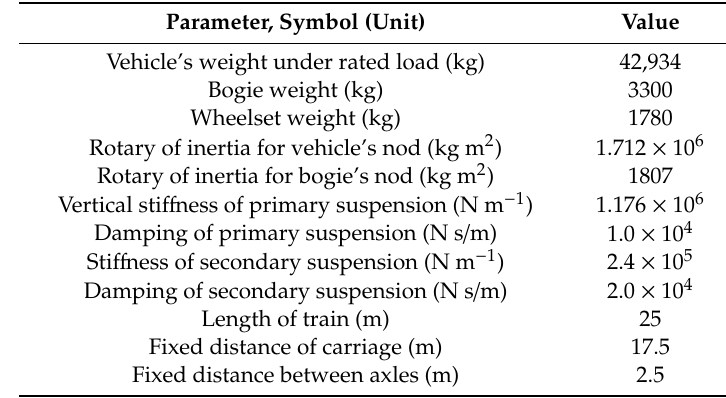
Table 2. Model parameters of CRH380A high-speed train.